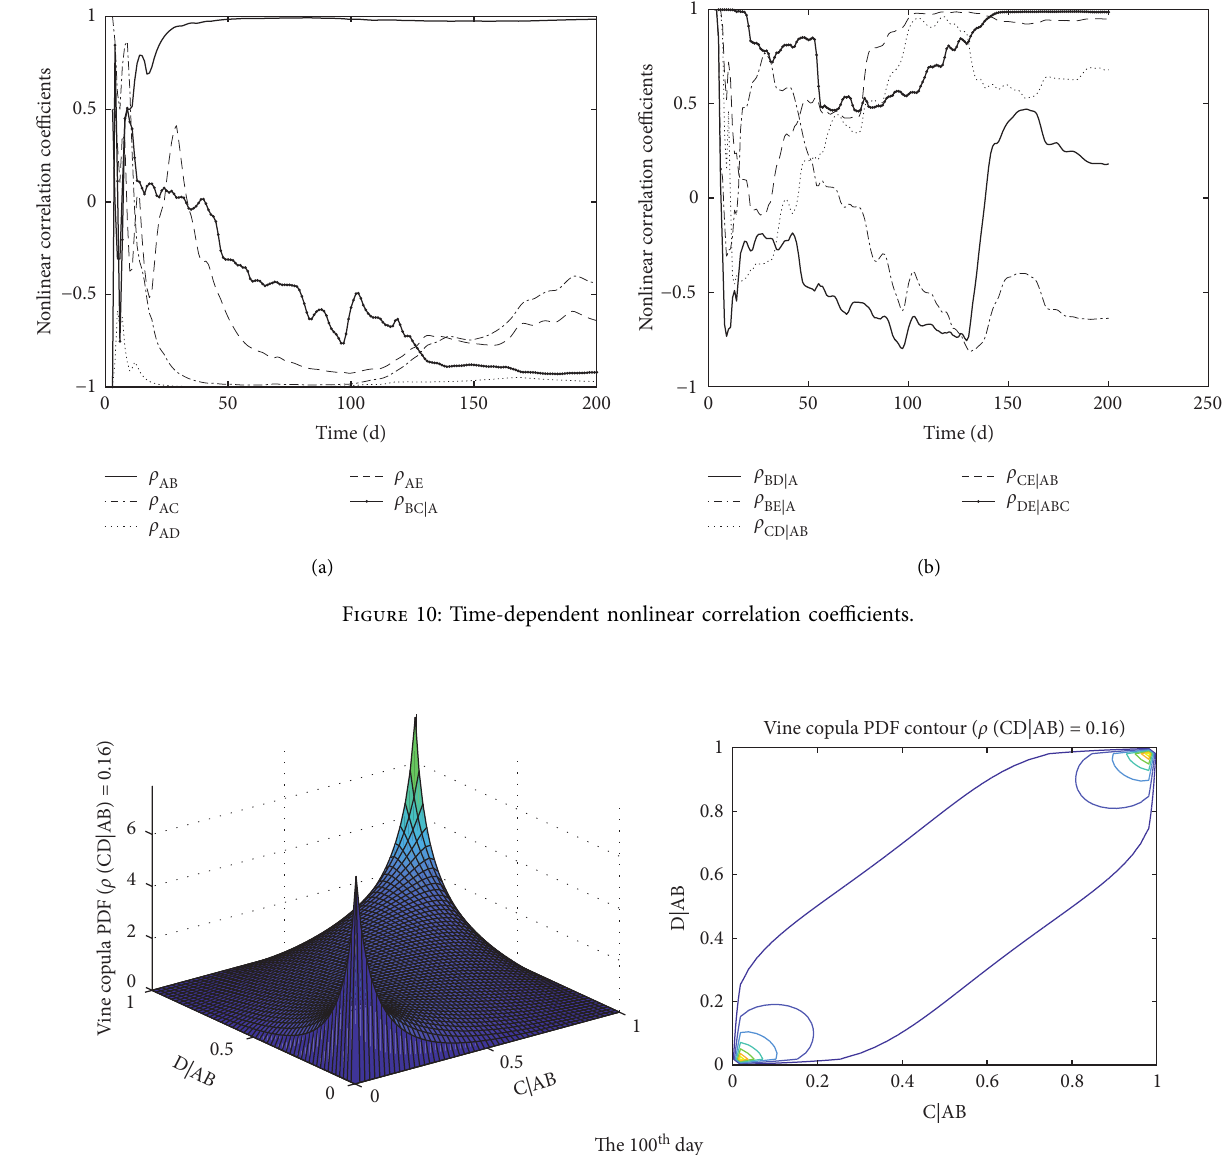
Figure 11: The time-variant correlation between sections C and D conditional on sections A and